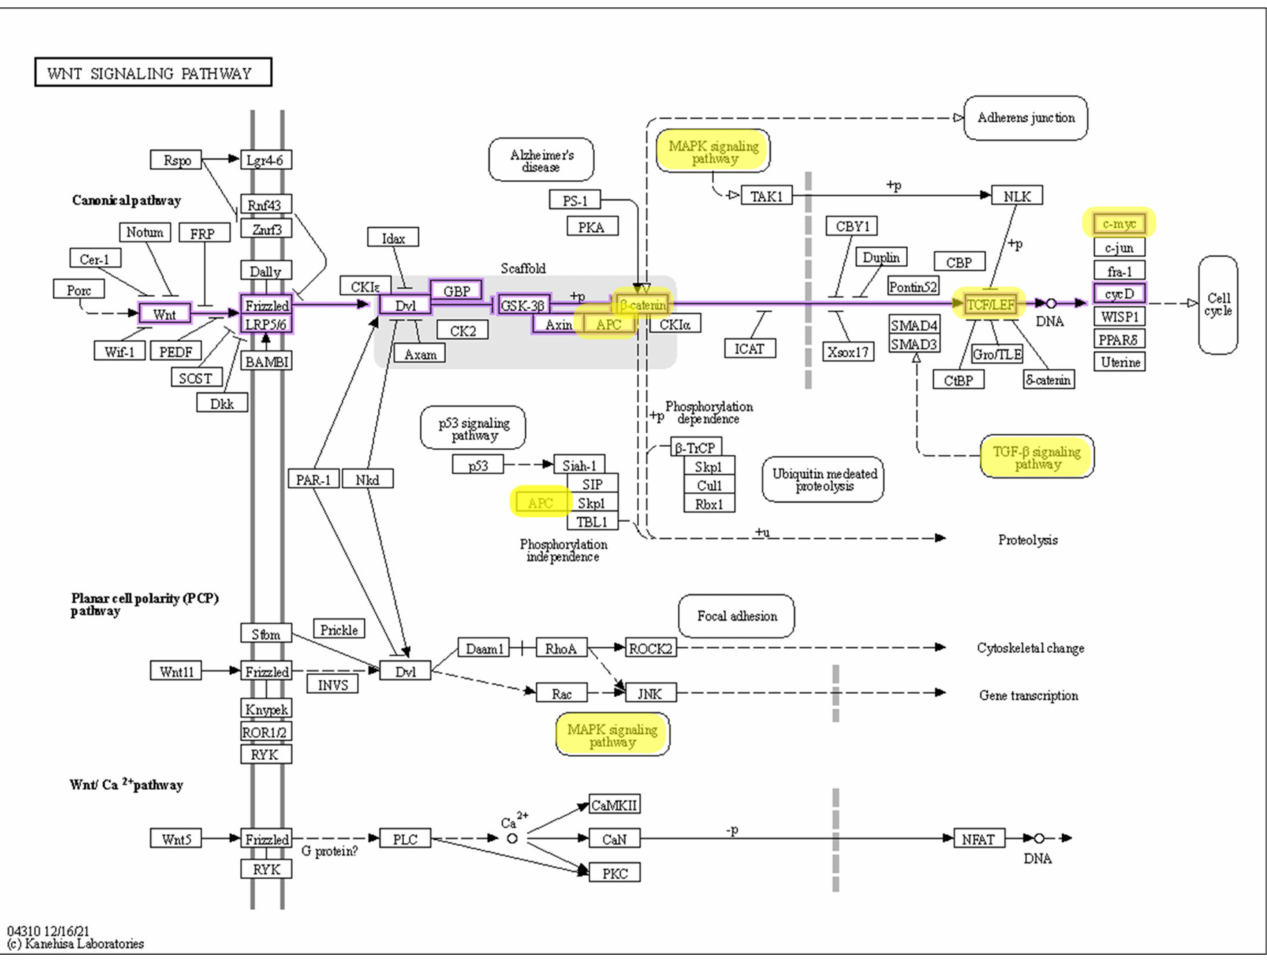
Figure 2. Wnt signaling pathway. Three pathways are shown—canonical, planar cell polarity (PCP), and Wnt/Ca 2+ . Molecules, pathways, and interactions implicated in CRC are highlighted. Reproduced from [44] with